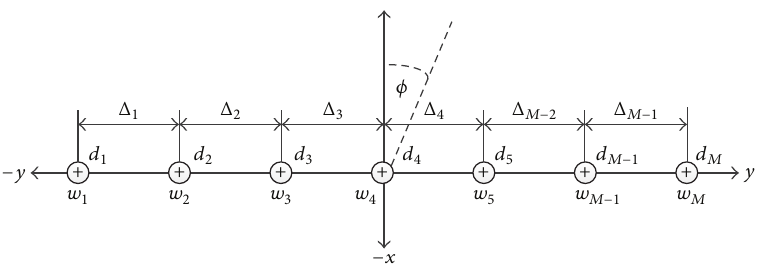
Figure 1: Geometry of nonuniform excitation coefficients and array range of a linear array antenna with 𝑀